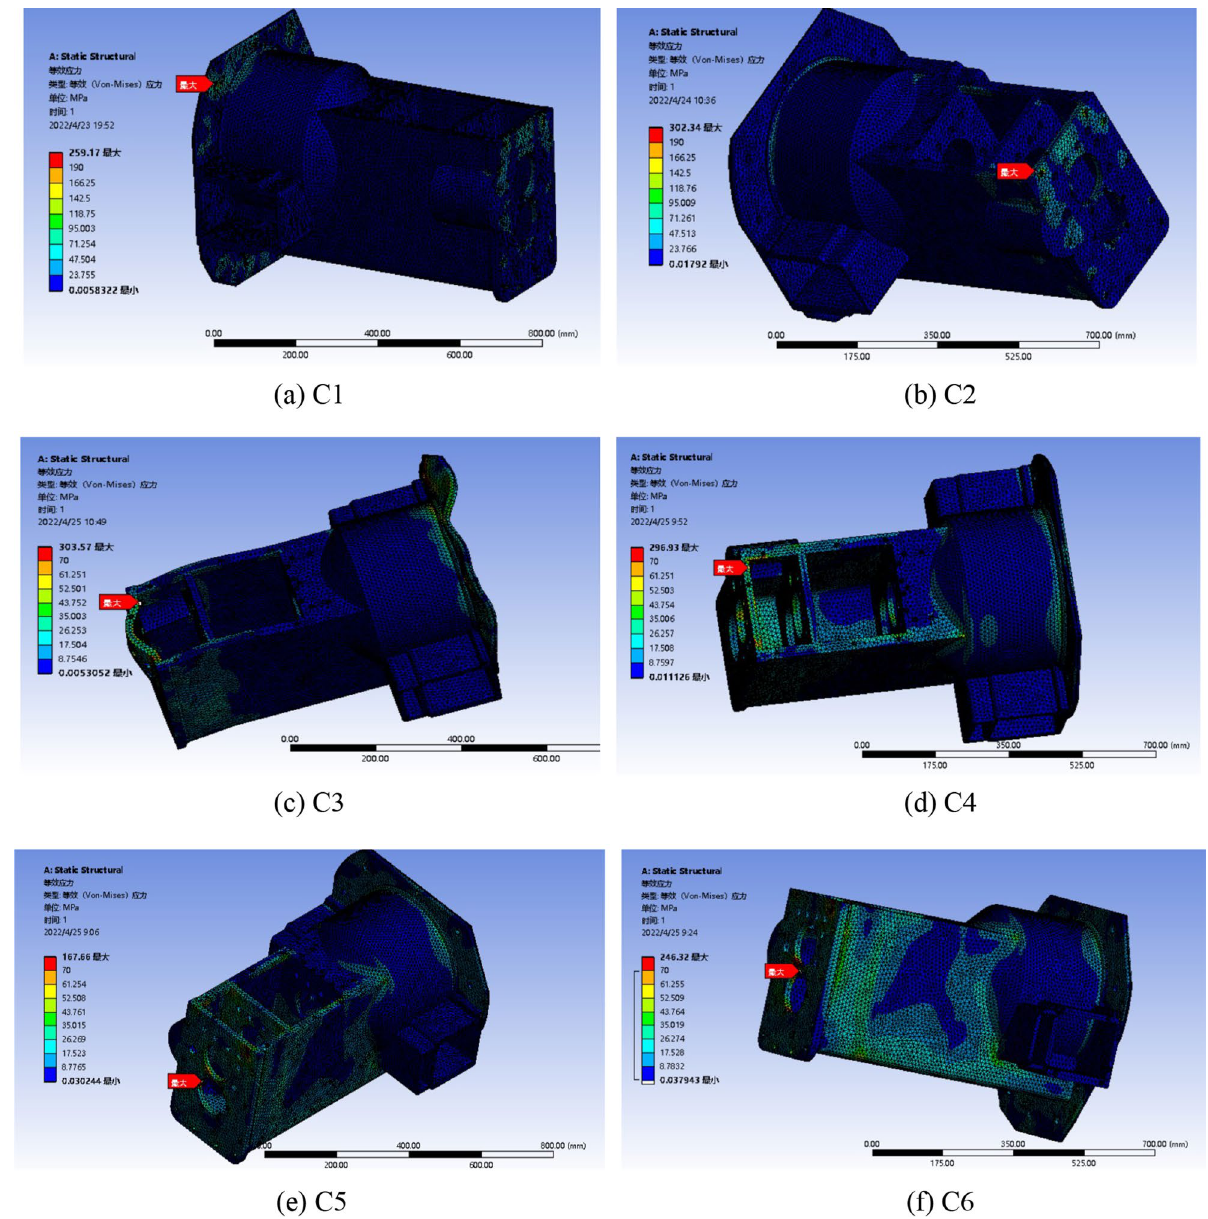
Figure 9. Stress nephogram of the box under different working conditions.